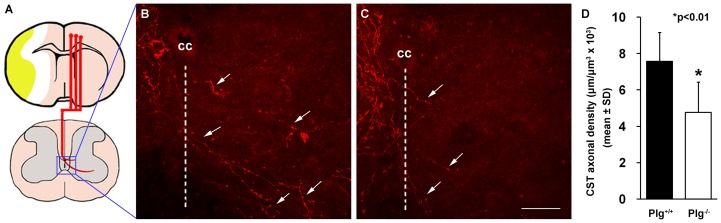
BDA-labeling of CST originating from the contralesional intact hemisphere.A: A schematic drawing shows BDA injection into the contralesional cerebral cortex and the location of pictures in B and C taken in the central area of the spinal gray matter. B and C: Representative confocal pictures from the Plg+/+ and Plg-/- mice showing midline-crossing BDA-positive CST axons (arrows) sprouted into the denervated side of the ventral gray matter after stroke. D: Quantitative data showing that the length of BDA-labeled CST axons in the denervated side of the cervical cord was significantly decreased in Plg-/- mice, compared with Plg+/+ mice (n = 10/group, *p<0.01). CC stands for central canal. Broken lines indicate the midline of the spinal cord. Scale bar = 50 µm.